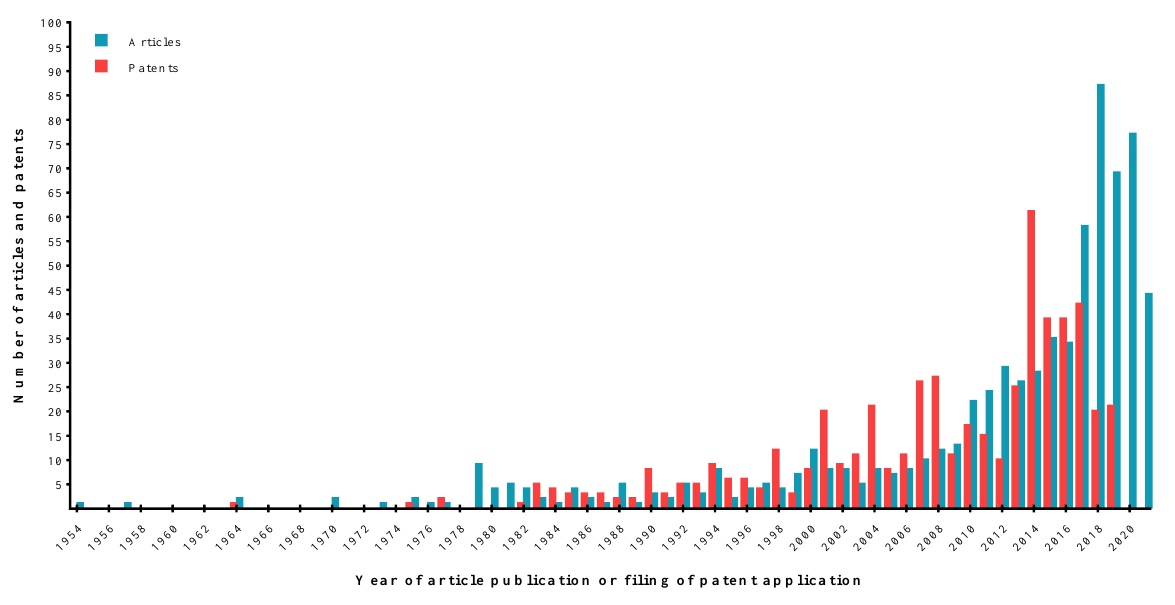
Figure 4. Number of published articles and patent documents filed regarding the participation of family farming in the development of new food products, between 1954 and 2021.